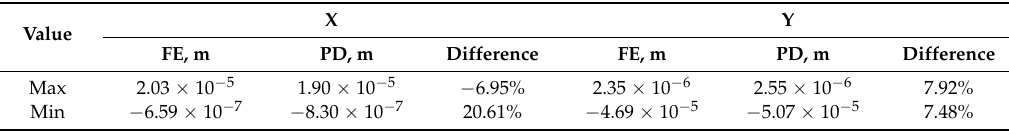
Figure 4. The displacement in the cross-section of an undamaged model: ( a ) the Y displacement finite element (FE) model; ( b ) the Y displacement PD model; ( c ) the X displacement FE model; ( d ) the X displacement PD model. Deformations are increased 50 times. Table 2. Maximum and minimum displacement values in the X and Y directions from the finite-element (FE) and Peridynamic (PD) simulations.